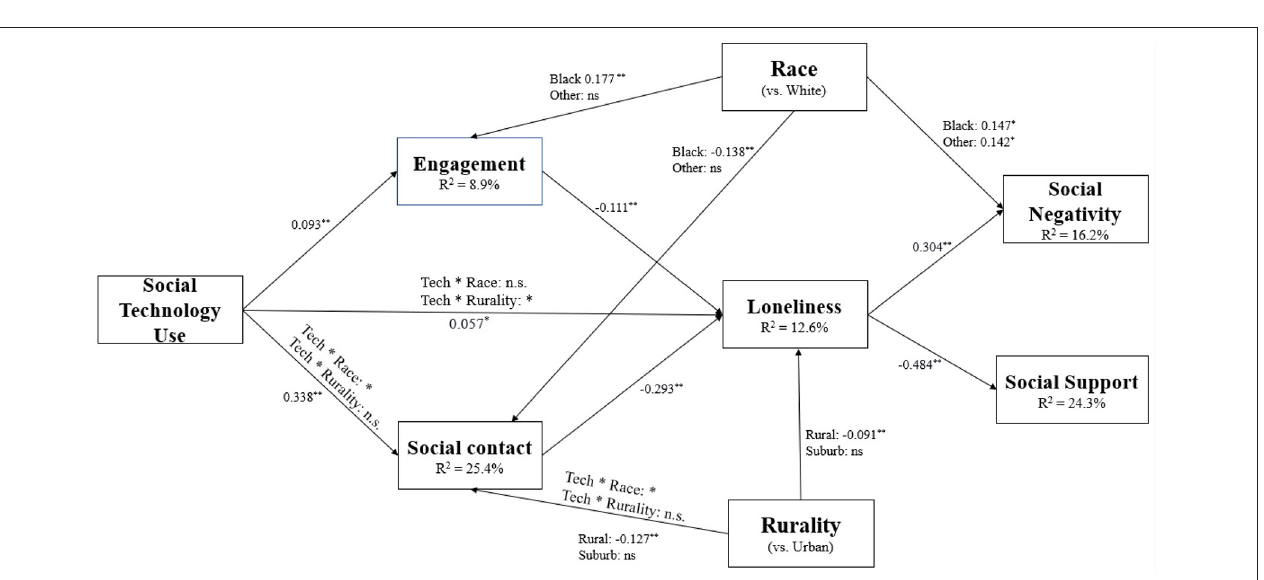
FIGURE 2 | Path model results ( N = 4,315) of the path model with social technology use predicting loneliness as moderated by race and rurality and mediated by social engagement and social contacts. The figure shows direct paths between variables. Path parameters represent standardized coefficients. *indicates p < 0.01. **indicates p <